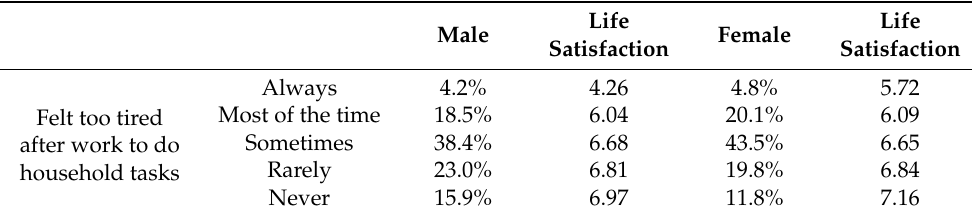
Table 3. Worries and life satisfaction of men and